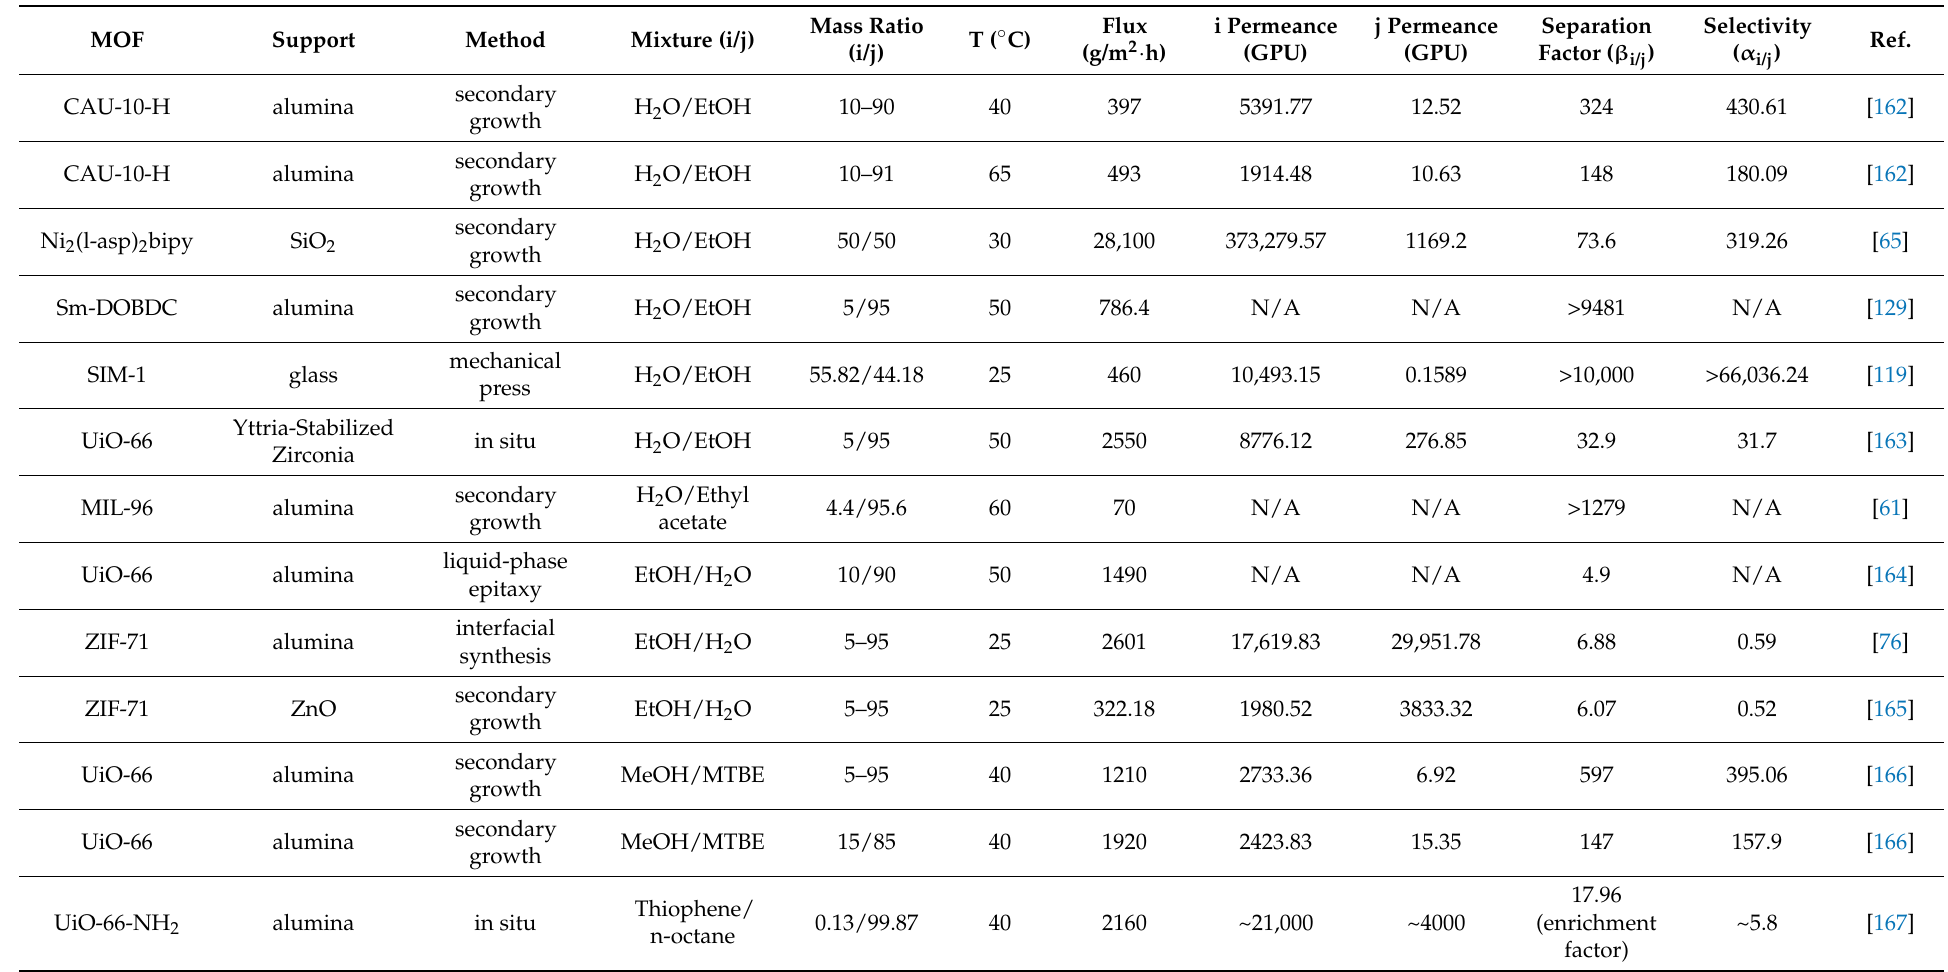
Table 4. Continuous MOF membranes for